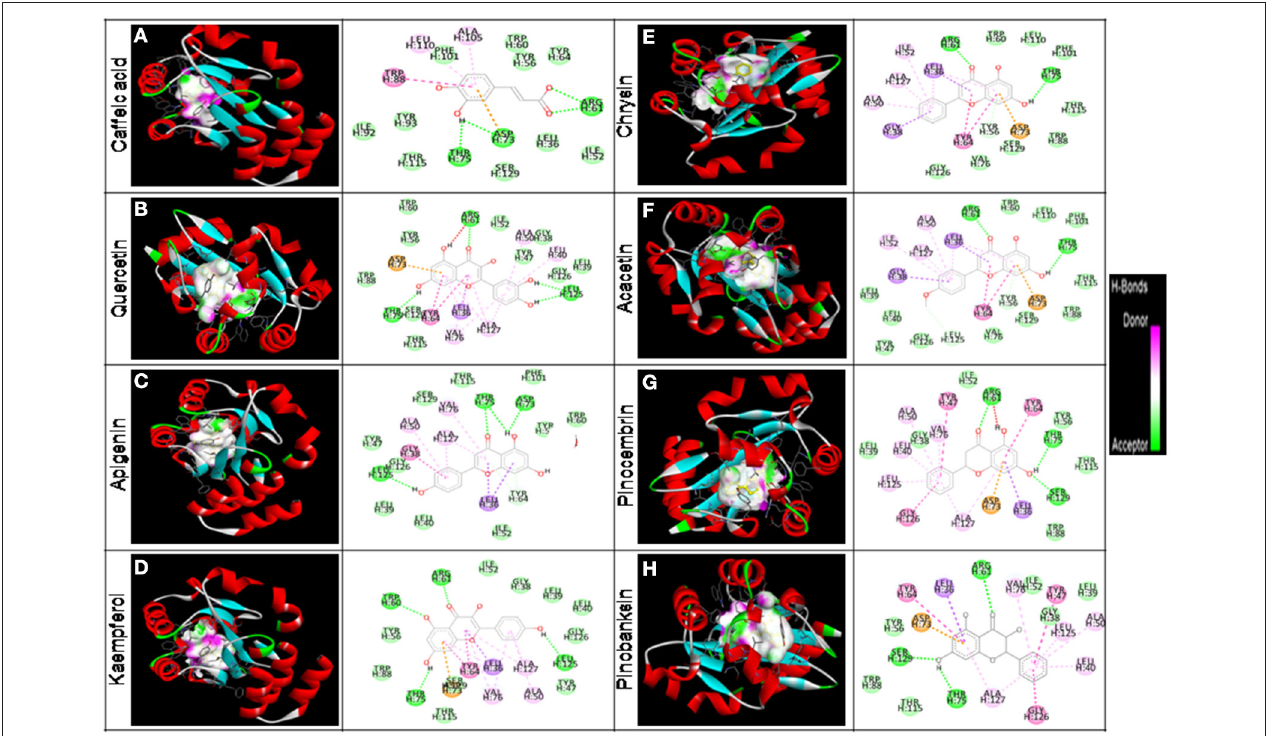
FIGURE 8 | In silico molecular docking analyses for determination of interaction between HP and LasR protein. HP are bounded (black color) in the binding cavity of LasR protein and colored by hydrogen bond character, with receptor donor colored in pink and receptor acceptor in green. A 3D depiction of binding orientation in LasR protein by (A) caffeic acid, (B) quercetin, (C) apigenin, (D) kaempferol, (E) chrysin, (F) acacetin, (G) pinocembrinand (H) pinobanksin. Hydrogen bondings and hydrophobic interactions between the surrounding amino acid residues and the ligand are also displayed.